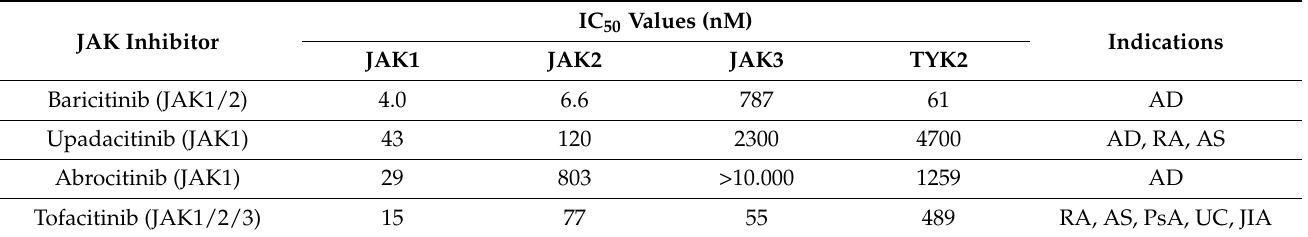
Table 3. JAK selectivity of systemic JAK